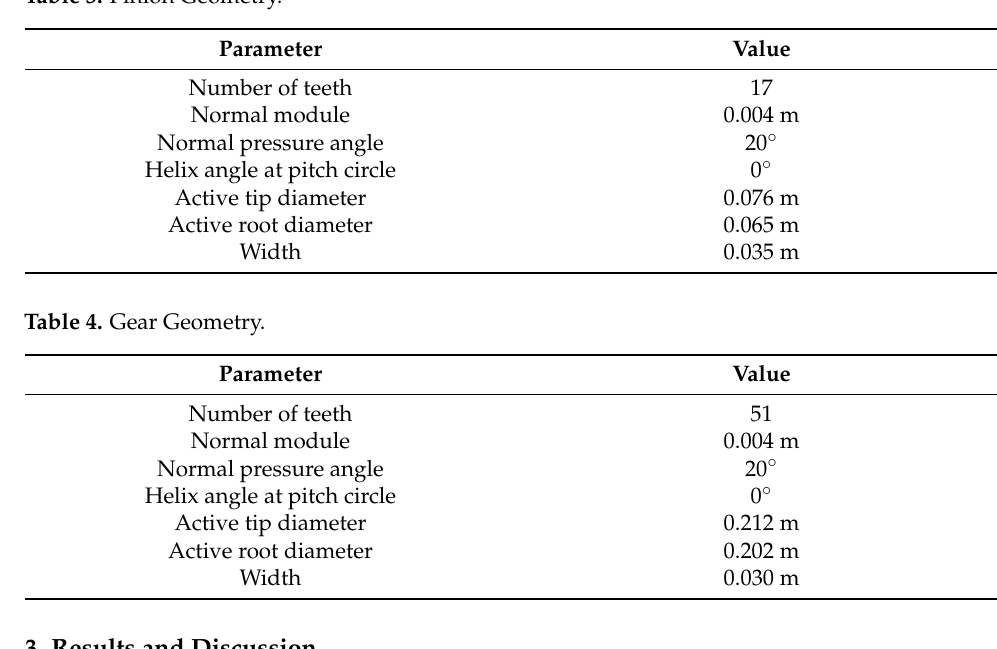
Figure 6. PMSM Torque Profile and Maximum and Minimum Torque Fluctuation. The gear pair geometry is shown in Tables 3 and 4. Table 3. Pinion Geometry.